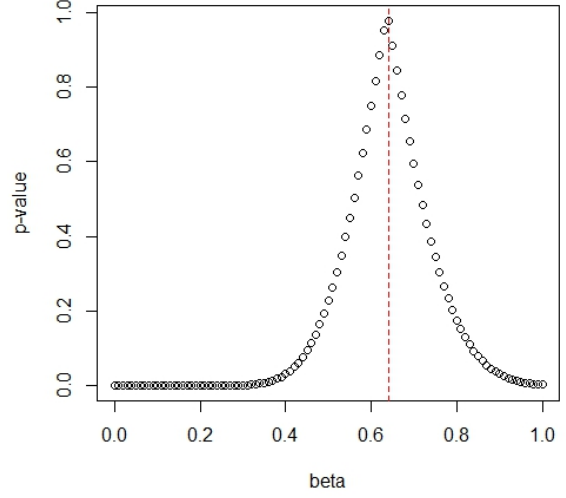
Figure 10. The p -value vs. the β values.